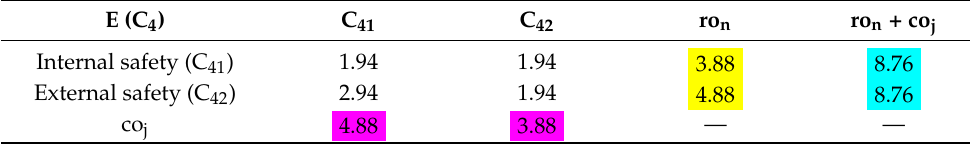
Table 19. Total direct influence matrix T between Safety (C 4 ) sub-criteria. E (C 4 )